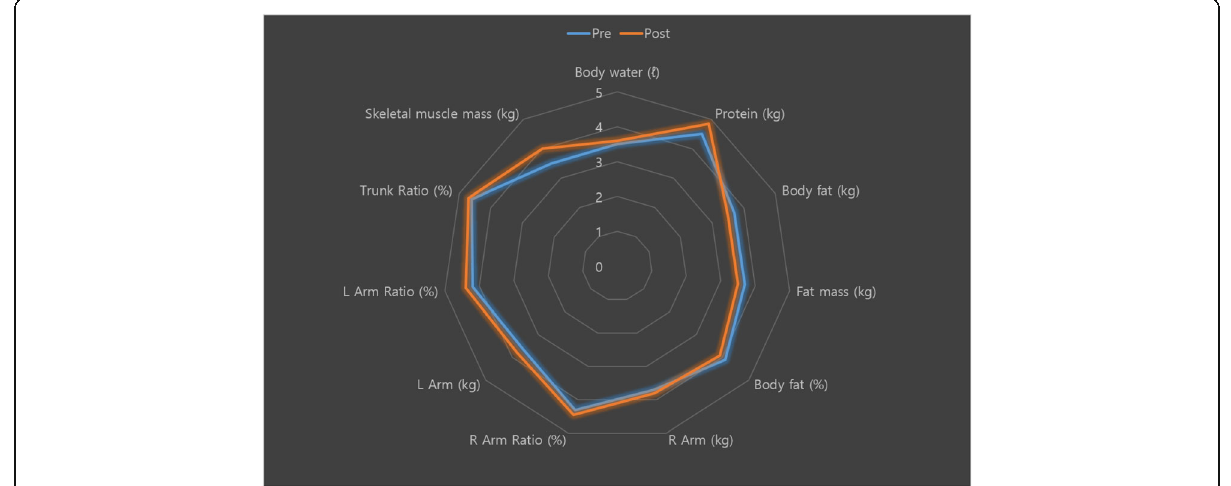
Fig. 2 The effect of sports VR training on human body composition (5-point